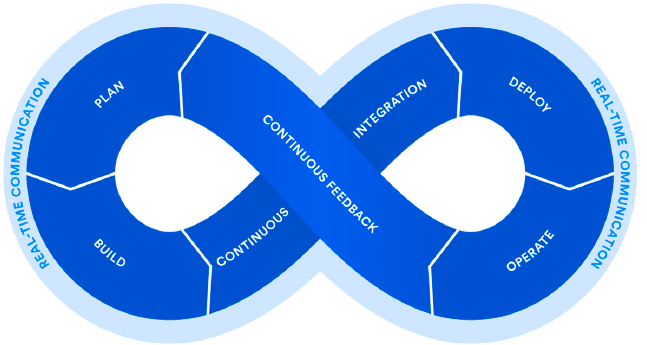
Figure 1. DevOps lifecycle (Source: Atlassian).